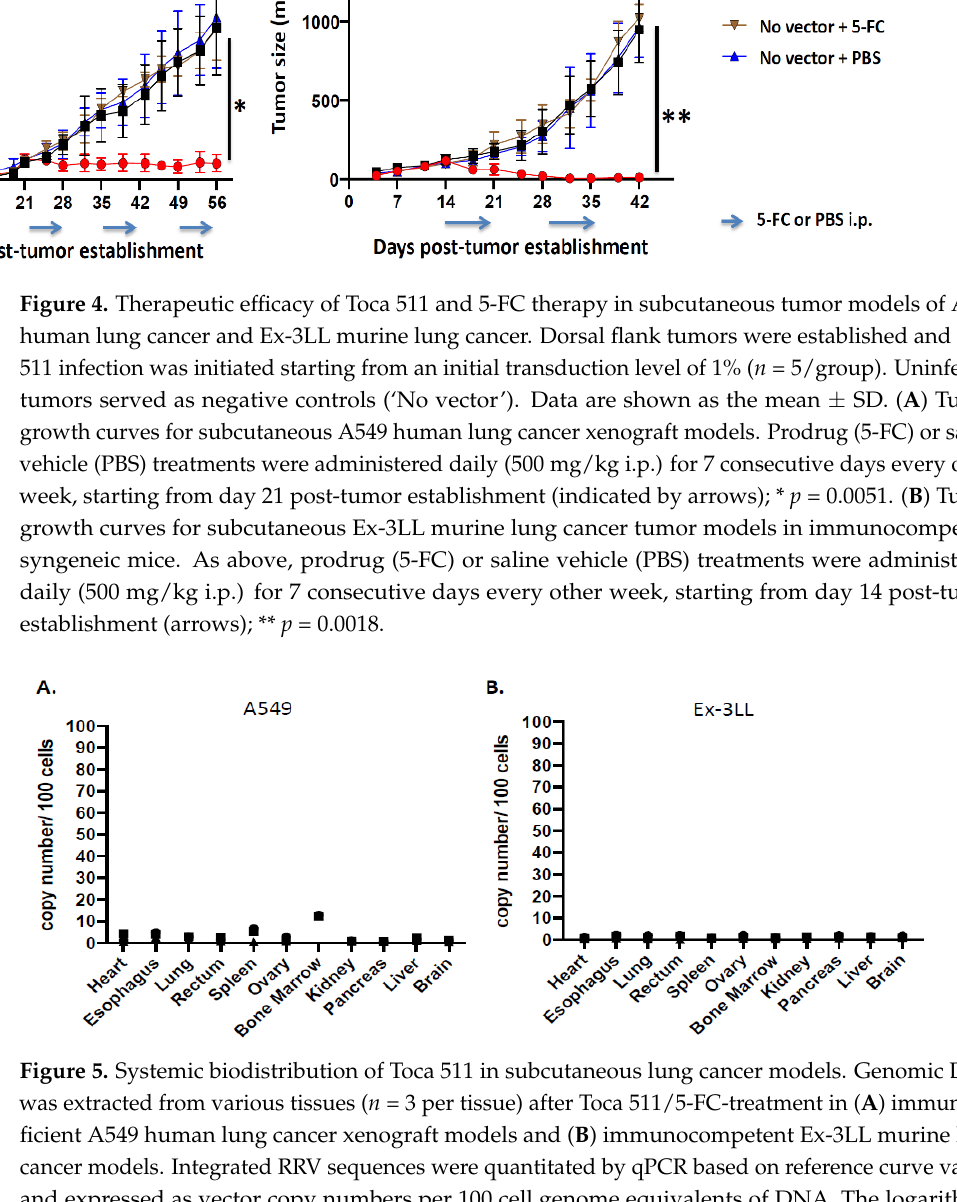
Figure 5. Systemic biodistribution of Toca 511 in subcutaneous lung cancer models. Genomic DNA was extracted from various tissues ( n = 3 per tissue) after Toca 511/5-FC-treatment in ( A ) immuno- deficient A549 human lung cancer xenograft models and ( B ) immunocompetent Ex-3LL murine lung cancer models. Integrated RRV sequences were quantitated by qPCR based on reference curve values and expressed as vector copy numbers per 100 cell genome equivalents of DNA. The loga- rithmic graph was shown in supplementary Figure S2.